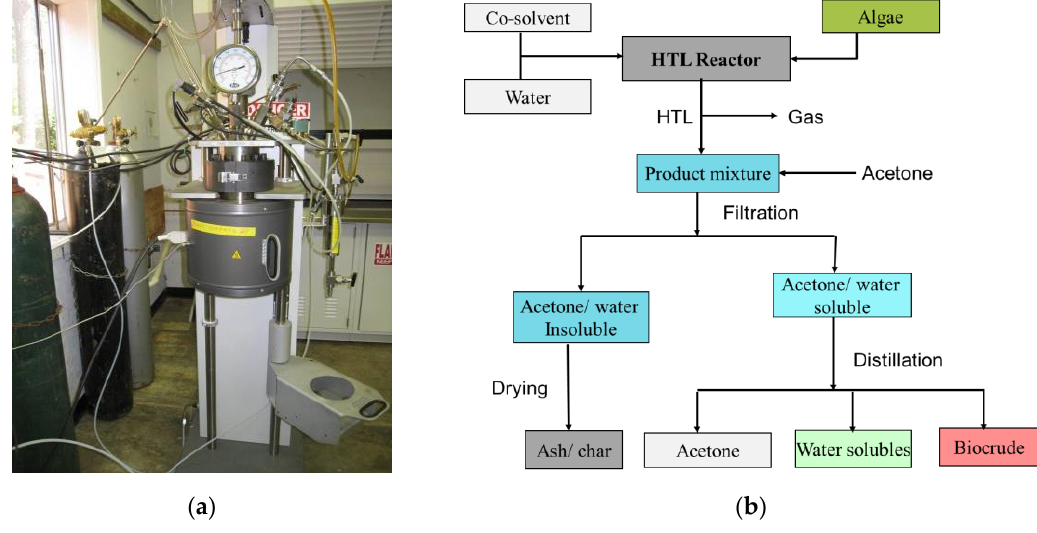
Figure 1. ( a ) 1.8-L Parr reactor apparatus for hydrothermal liquefaction (HTL) and hydrodeoxygenation (HDO) experiments; ( b ) HTL products separation protocol.